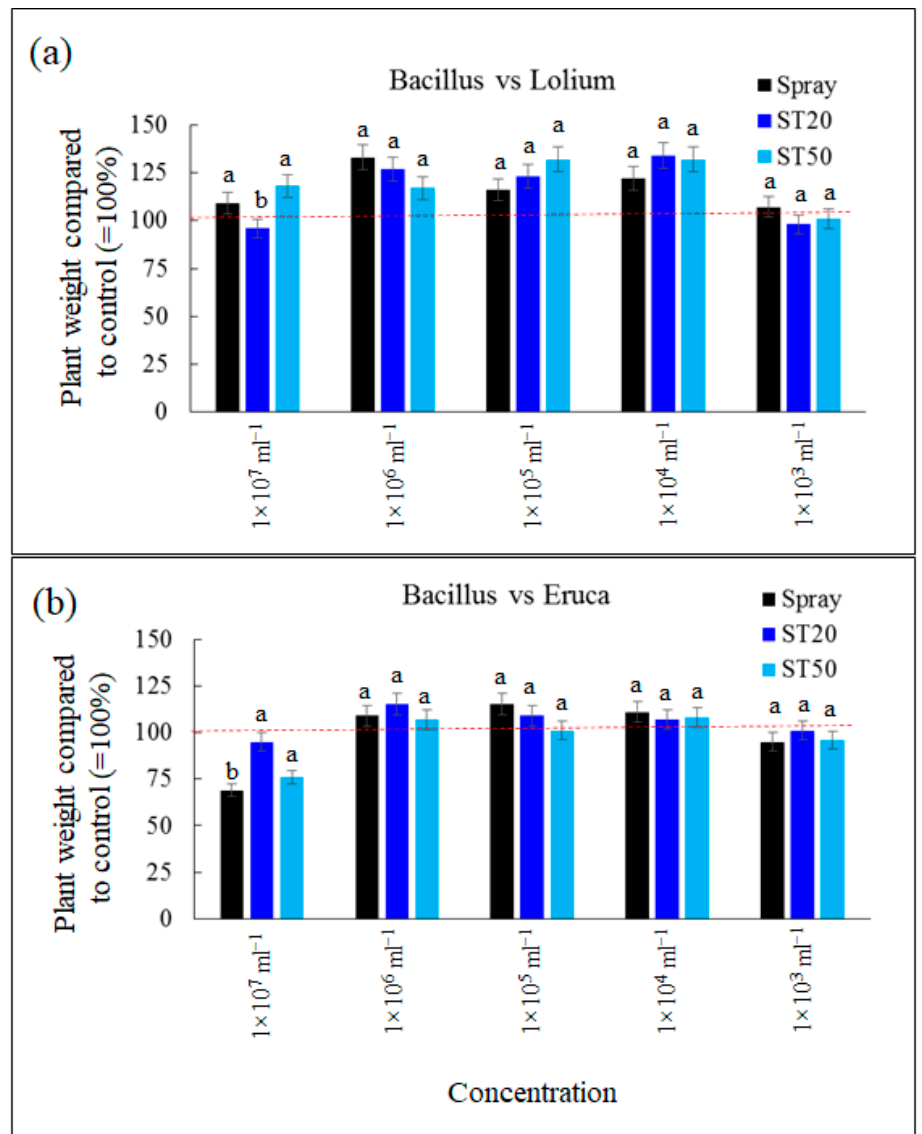
Figure 11. Growth of Lolium perenne ( a ) and Eruca vesicaria ( b ) treated with Bacillus subtilis at five concentrations with spray system, ST20, and ST50. Data are means ± standard deviation; different letters indicate statistically significant differences within concentration (Duncan’s test). The red line indicates the growth of the untreated control.